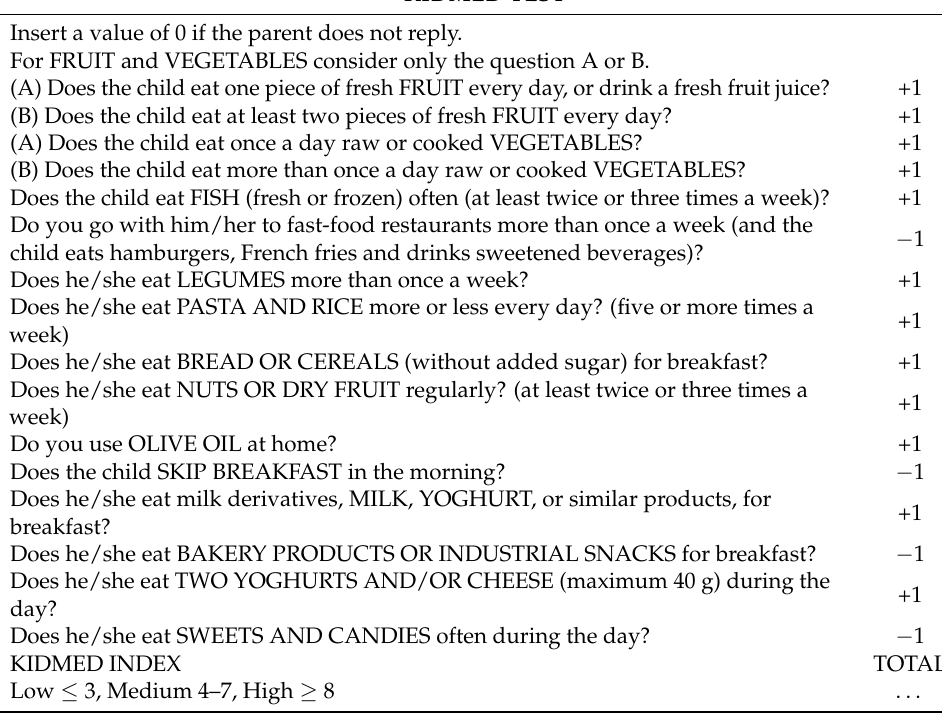
Table 1. KIDMED test, modified and adapted for this study from Serra-Majem [20]. KIDMED